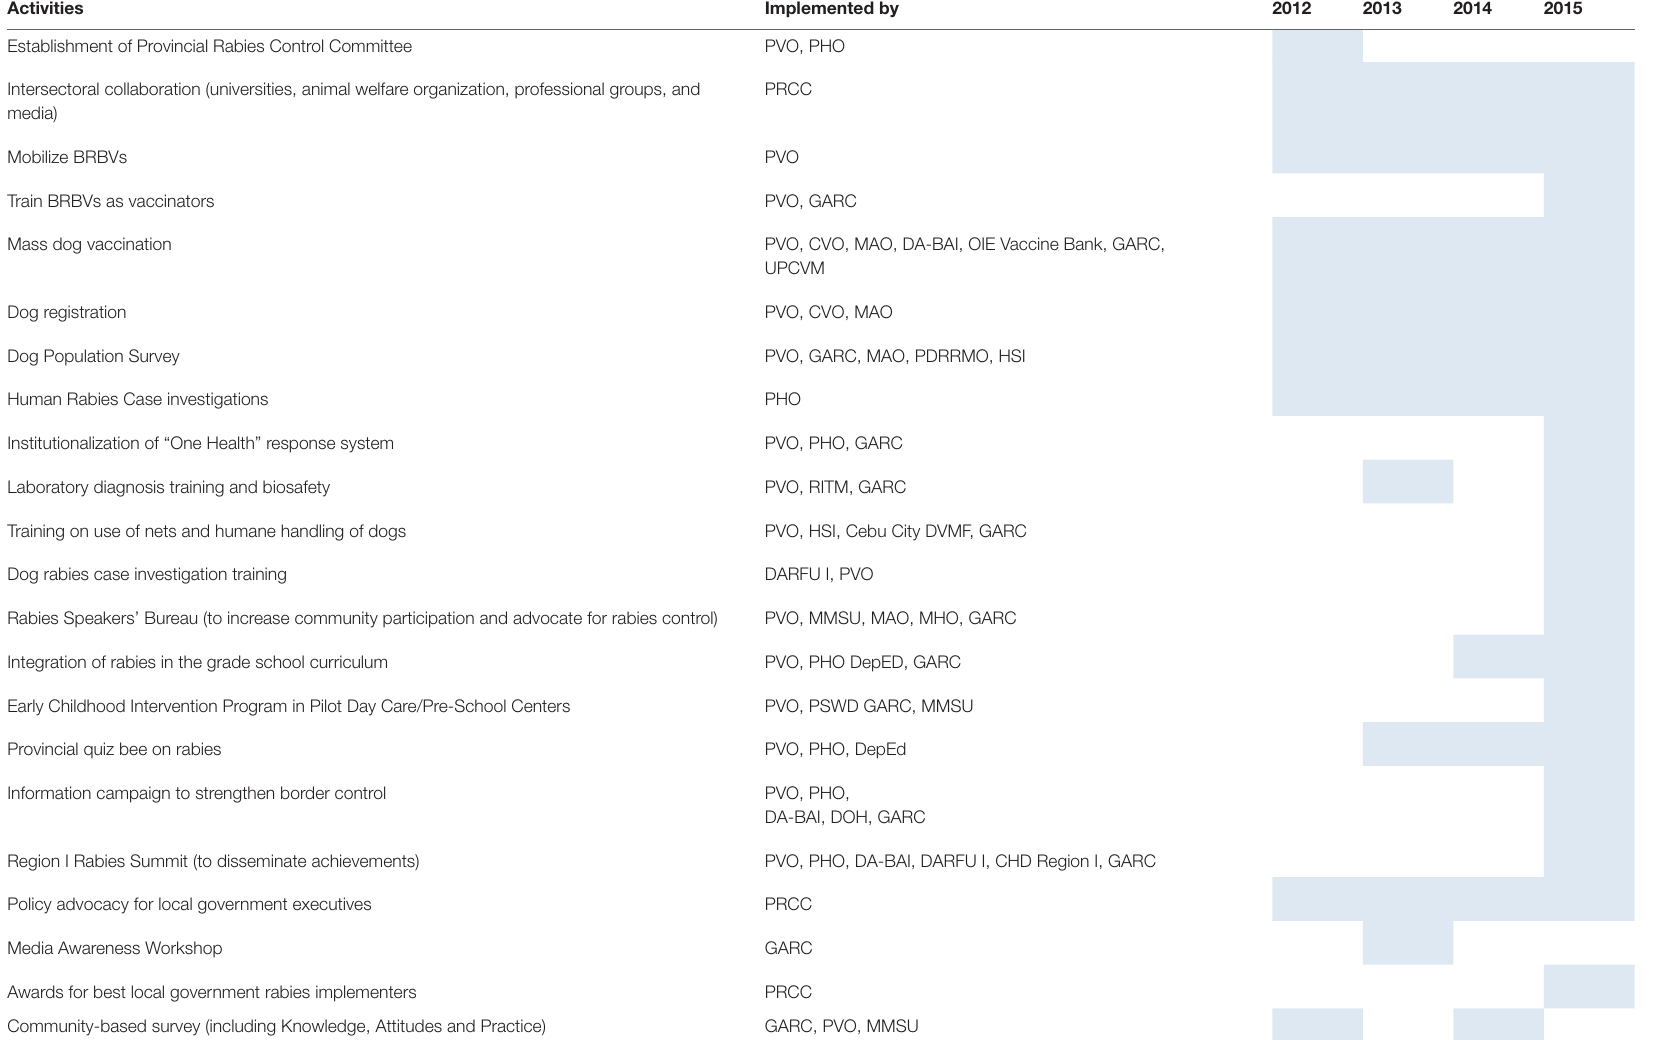
TaBle 1 | rabies prevention and control activities implemented as part of the ilocos norte rabies